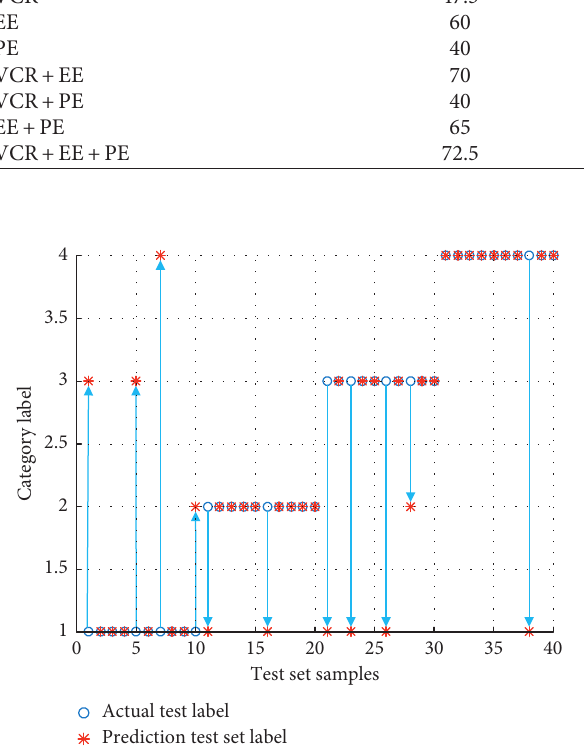
Figure 16: The comparison of VMD test results.